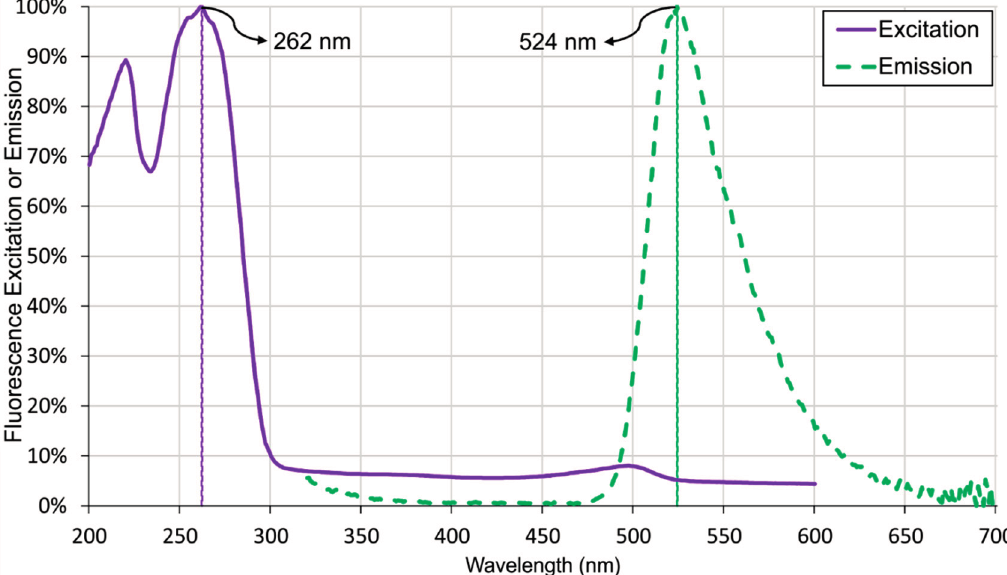
Figure 5. Spectrogram of LAMP Amplicons with Salmonella